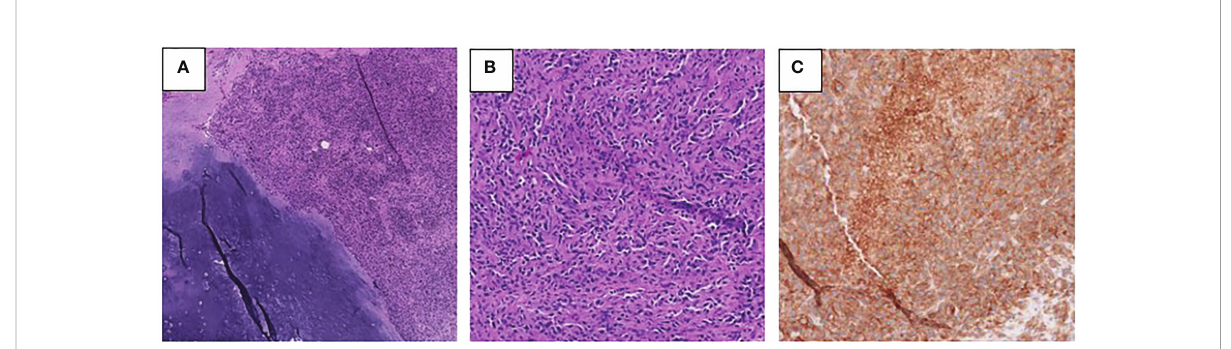
FIGURE 3 (A, B) Photomicrographs of the right femur tumor showing low-grade chondrosarcoma with adjacent dedifferentiated component (A) and the high-grade dedifferentiated component (B) (H&E). (C) PD-L1 immunohistochemical stain performed on the right femur tumor demonstrates membranous immunoreactivity in tumor